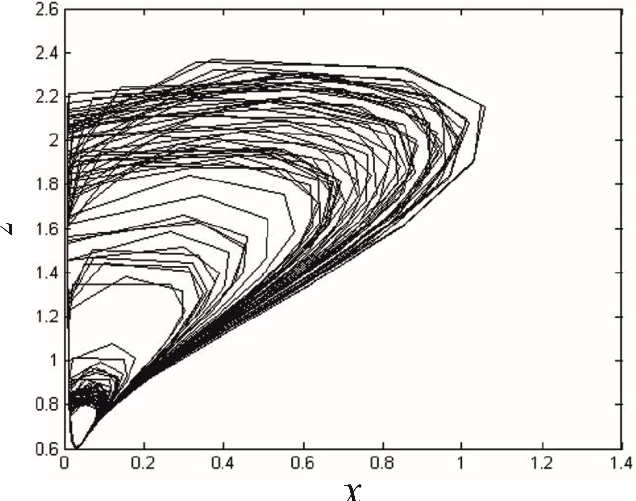
Figure 4. Bidimensional attractor ( x , z ) with open cycle obtained for low flux in Györgyi–Field sys- tem: α = 6000/9; β = 8/23; A = 0.1 mol; C = 8.33 × 10 −4 mol; M = 0.25 mol; H = 0.26 mol and k f = 3.9 × 10 −4 .